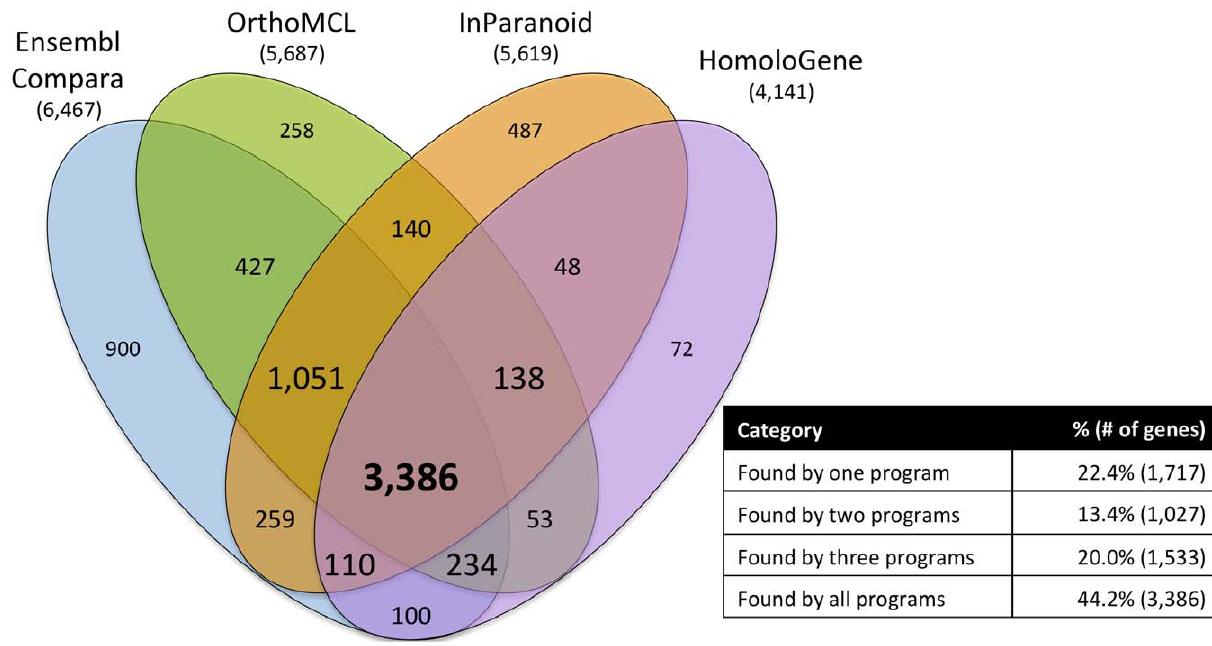
Figure 1. Comparison of four orthology prediction programs queried for C.elegans orthologs of human proteins. This diagram is modified from VENNY (see Materials and Methods). Each program is named above the oval representing its results, with the number of C. elegans orthologs and in-paralogs found by the program shown. The table gives an overall measure of how many genes were found by one or more programs (regardless of which one(s) found them). The numbers in the overlapping and non-overlapping areas of the Venn diagram indicate how many genes were found by overlapping or unique sets of programs. The font size used for these numbers indicate how many programs that number of genes was found by: numbers corresponding to genes found by a single program are shown smallest, whereas the largest font denotes the number of genes found by all programs. The data underlying this diagram can be seen in Table S1. A measure of the similarity and divergence between programs can be found in Table